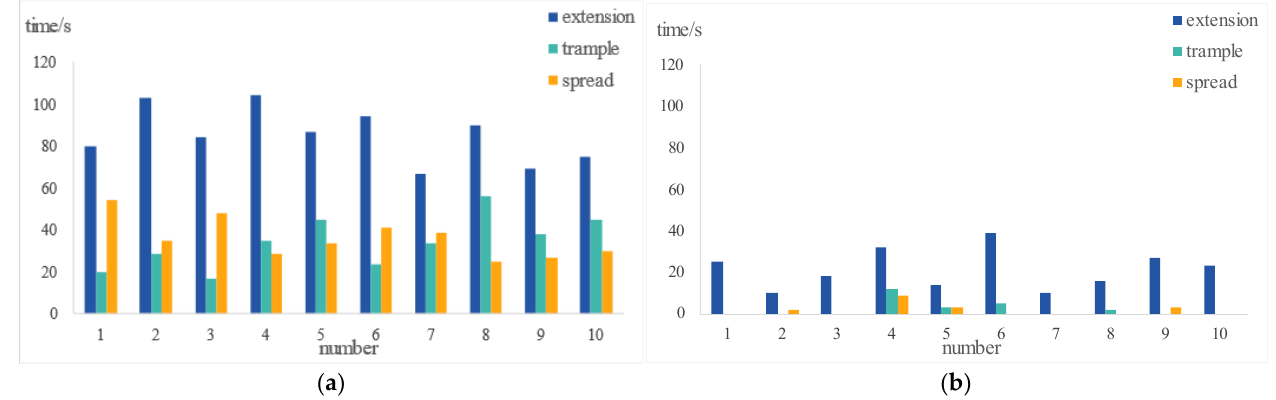
Figure 14. Statistics of behavior occurrence time. ( a ) time of behavior in emergency, ( b ) Time of behavior in non-emergency.